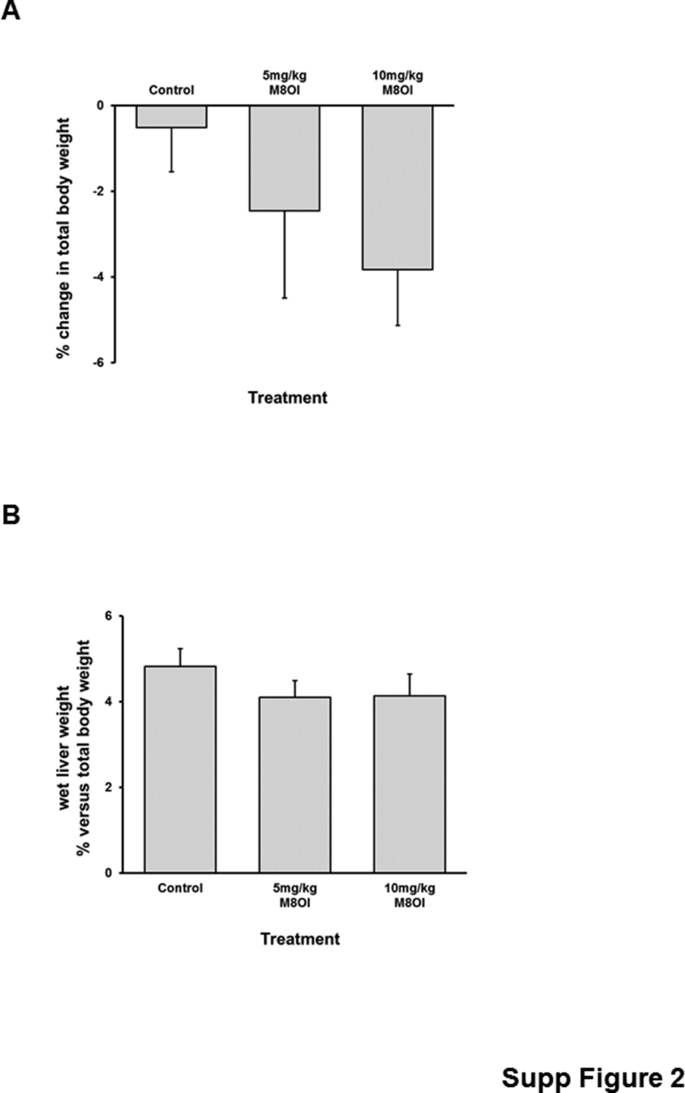
Effects of M8OI on body weight and relative liver weight. A, % change in body weight, expressed relative to starting body weight. B, wet liver weight expressed relative to terminal body weight. All data are the mean and SD of at least 3 separate animals per group. .